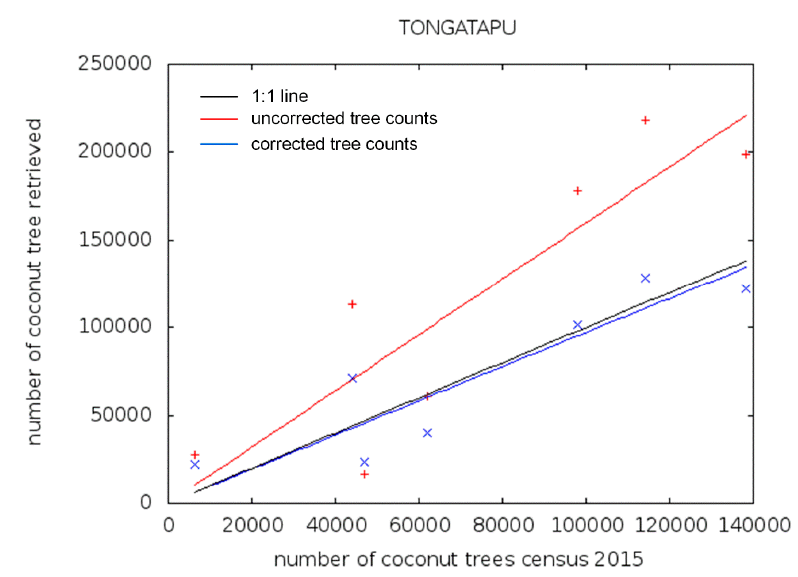
Figure 9. Comparison of the algorithm tree counts over Tongatapu with the original 2015 agricultural census data (uncorrected tree counts) and accounting for the allotted land area (corrected tree counts). Table 1. Comparison of the algorithm coconut tree counts to the results published in the 2015 agricultural census over the different parts of the Tonga archipelago. Allotted Tonga Census Satellite-Derived No. Area, Region No. of of Trees Uncorrected km 2 s Trees